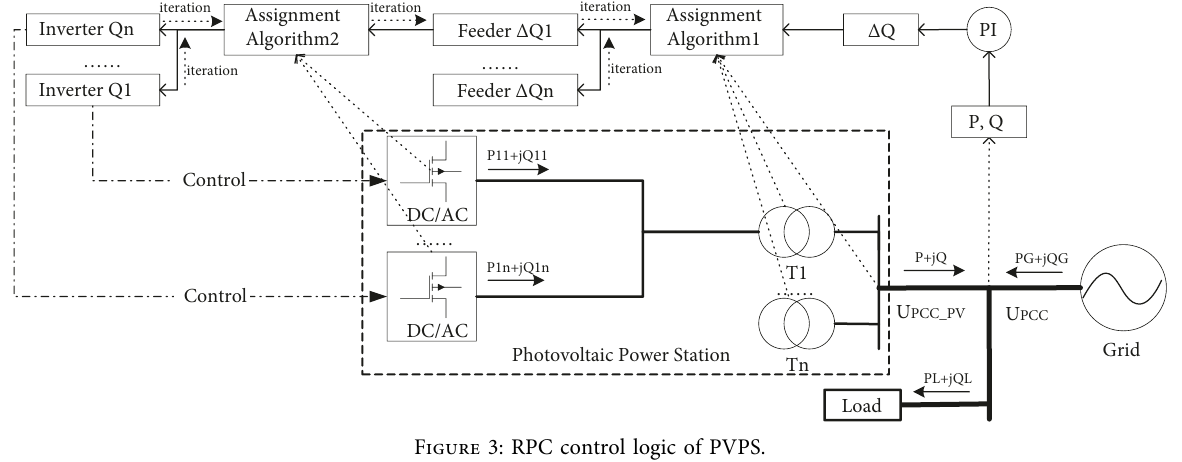
Figure 3: RPC control logic of PVPS.